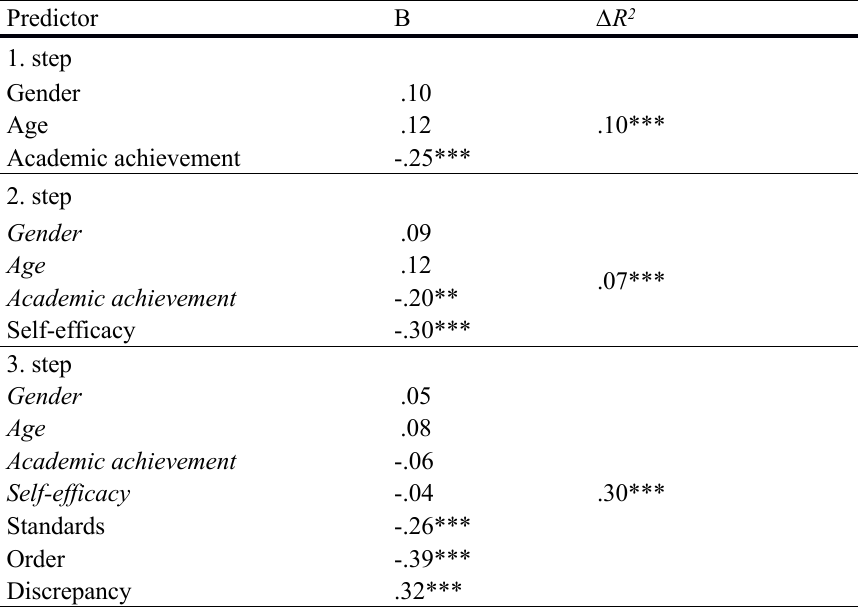
Table 3. Summary of hierarchical regression analysis predicting procrastination